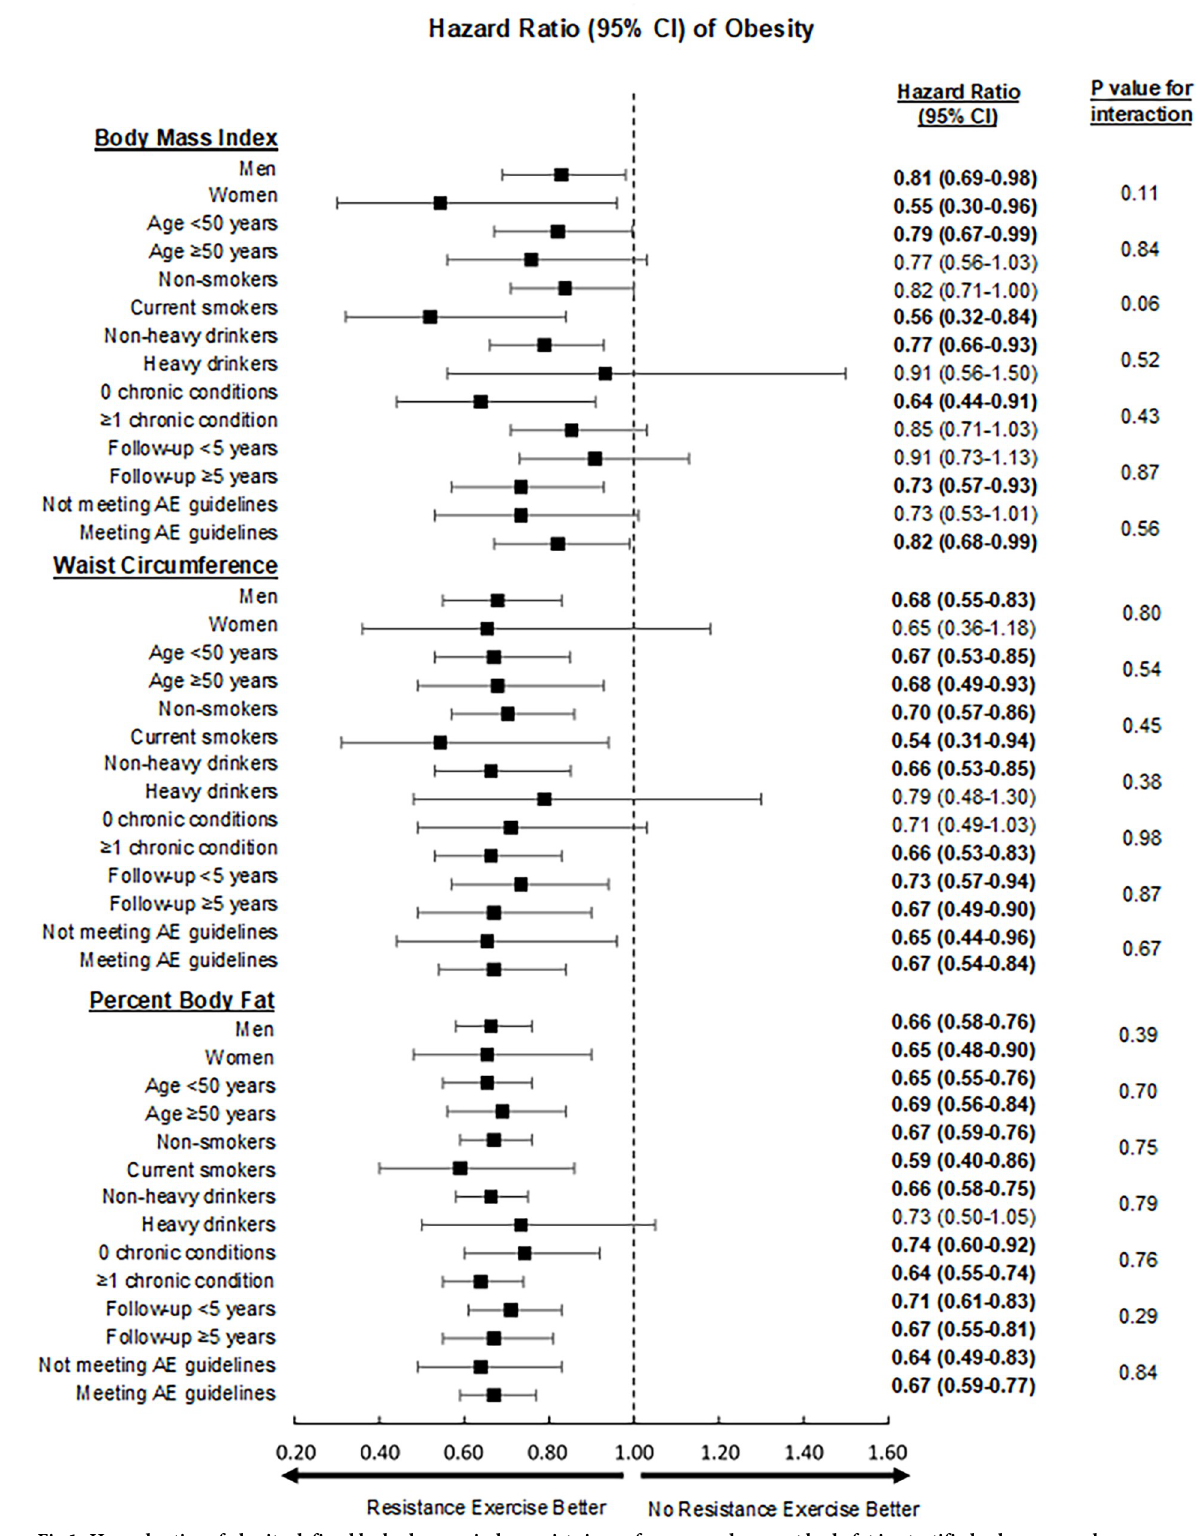
Fig 1. Hazard ratios of obesity defined by body mass index, waist circumference, and percent body fat in stratified subgroup analyses. Hazard ratios are depicted by black boxes, and 95% confidence intervals by whiskers. The reference group for all analyses was those